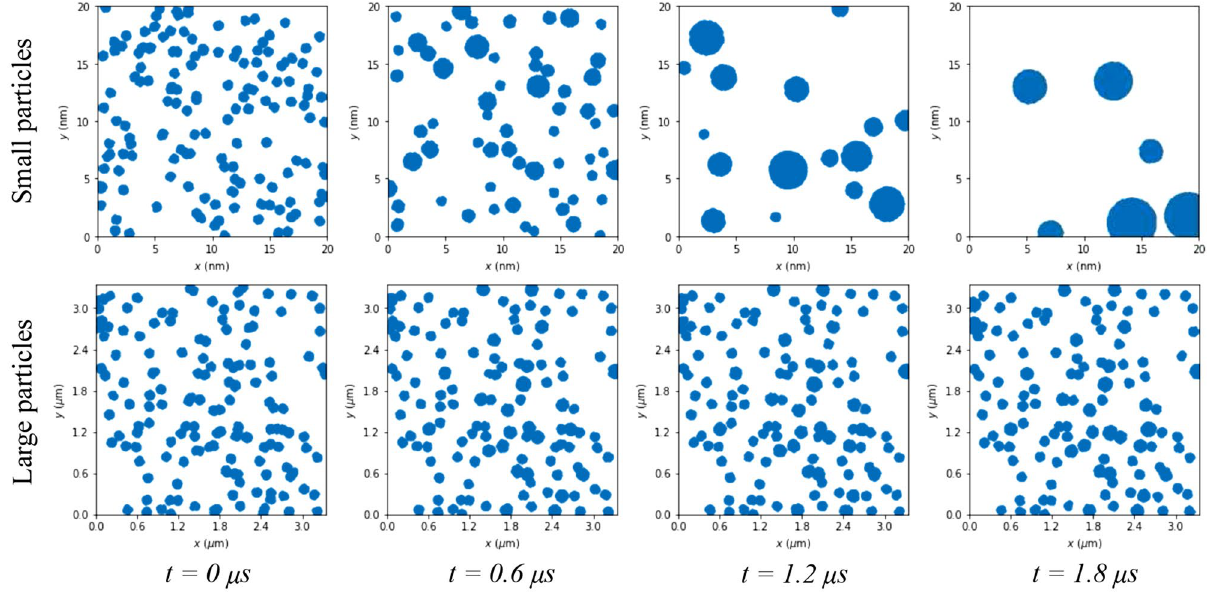
Figure 8. Evolution of the simulated particle densities after different time steps for small and large particles, showing its effect on the island sizes in the cases of µ -YBCO and n-YBCO,